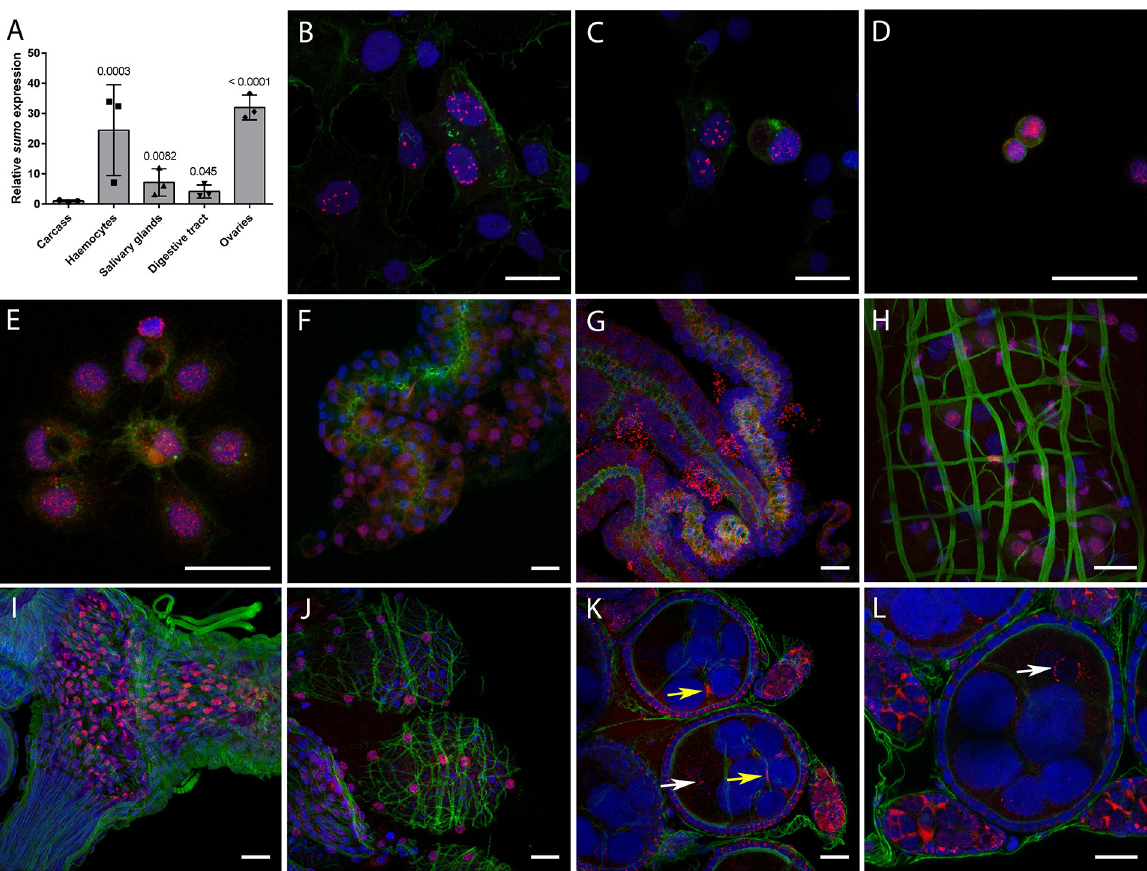
Fig 4. Aa SUMO is differentially expressed in Ae . aegypti tissues. (A) RNA was extracted from perfused haemocytes, dissected salivary glands, digestive tracts, ovaries, and carcasses (pools of 25 digestive tracts, ovaries or carcasses, 60 salivary glands, or pooled perfused haemocytes from 70 females per replicate experiment, N = 3 independent experiments). cDNA was synthesised and RT-qPCR was conducted to examine mRNA expression of SUMO . Data were analyzed as described by Taylor et al . (78). SUMO expression values were normalized to ribosomal S7 as a reference transcript, with a RQ geometric mean (geomean) of 1 for carcass. SD shown. Log2-normalized expression values were used for statistical analyses; one-way ANOVA (F 4,10 = 17.99, p = 0.0001) followed by a Dunnett multiple comparison test relative to carcass (p values shown). (B to L) Representative confocal microscopy images showing the expression and sub-cellular localization of SUMO (red) in Ae . aegypti cells and tissues as detected by immunofluorescence assay. (B,C) AF5 cells; (D) perfused prohaemocytes; (E) perfused granulocytes; (F,G) salivary glands and surrounding fat body; (H) midgut; (I) oviduct; (J) ovarioles surrounded by the ovarian sheath; and (K,L) primary previtellogenic follicle and germarium inside ovarioles. Nuclei are stained by DAPI (blue) and F-actin is stained by Phalloidin 488 (green). Bar = 20 μ m. Arrows indicate SUMO accumulation around the nucleus of the future oocyte (white) and at the perinuclear region of the nurse cells (yellow).